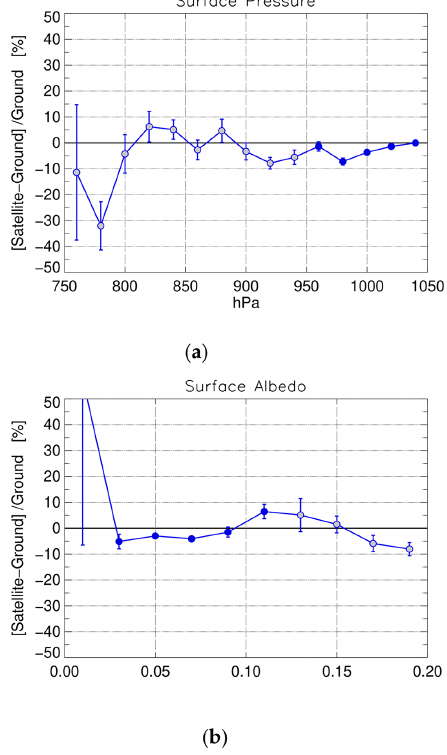
Figure 12. The dependence of the comparisons of satellite- to ground-based TCWV measurements on two surface parameters, namely (a) surface pressure and (b) surface albedo. In both panels, the error bars show the standard error of the mean with a confidence interval (CI) of 99.7%. Grey dots represent bins containing < 3% of the total co-location